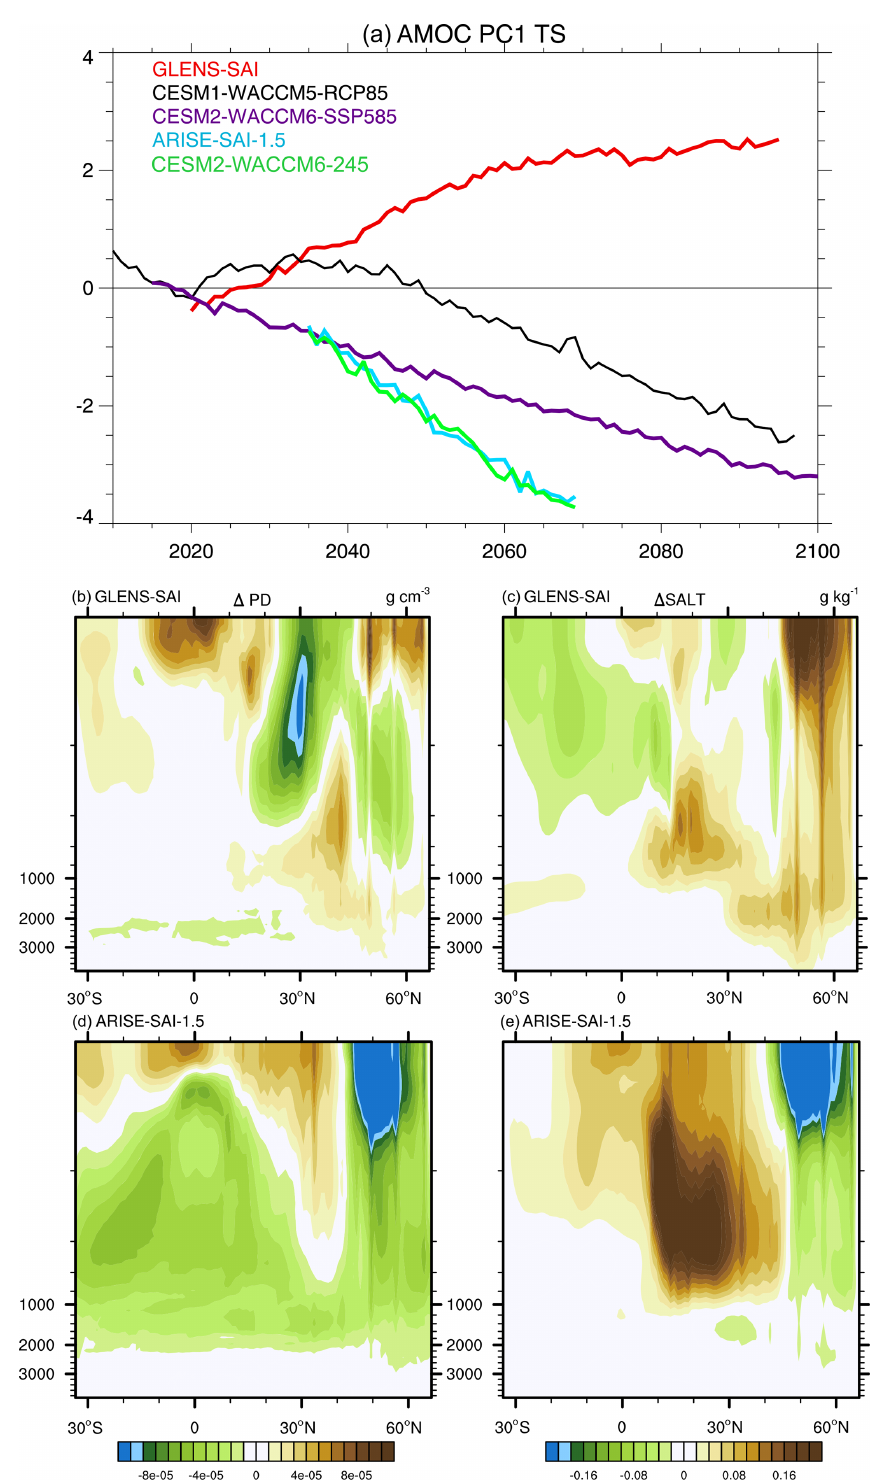
Figure 5. (a) Changes in the normalized leading principal component of the Atlantic meridional overturning circulation, which is unitless, in unmitigated (CESM1-WACCM5-RCP85, CESM2-WACCM6-SSP245, CESM2-WACCM6-SSP585) and mitigated (GLENS-SAI, ARISE- SAI-1.5) experiments. Also shown are changes between 2020–2039 and 2050–2069 in the latitude-depth structure in the Atlantic Ocean of ocean potential density (PD; b, d ; units of gcm − 3 ) and salinity (SALT; c, e ; units of gkg − 1 ) for GLENS-SAI (b, c) and ARISE-SAI- 1.5 (d, e) ,